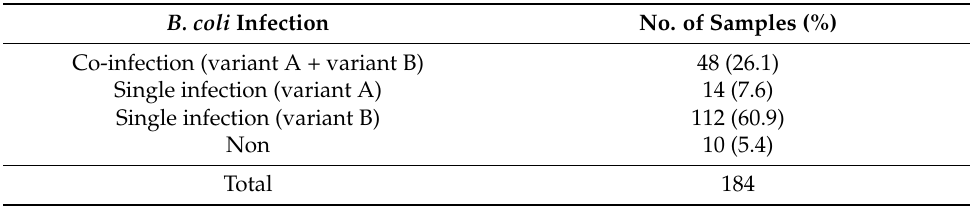
Figure 2. Polymerase chain reaction-restriction fragment length polymorphism (PCR-RFLP) re-sults of Balantioides coli variants A and B with restriction enzyme digests by Apo I and PflM I. M, marker; 1, B. coli variant A (537-bp); 2, B. coli variant B (528-bp); 3, B. coli variant A treated with Apo I (227, 135, 70, 35-bp); 4, B. coli variant B treated with Apo I (293, 235-bp); 5, B. coli variant A treated with PflM I (537-bp); 6, B. coli variant B treated with PflM I (312, 216-bp). Note that the 35-bp fragment is not visible. Table 3. Proportions of Balantioides coli genetic variants in pigs in